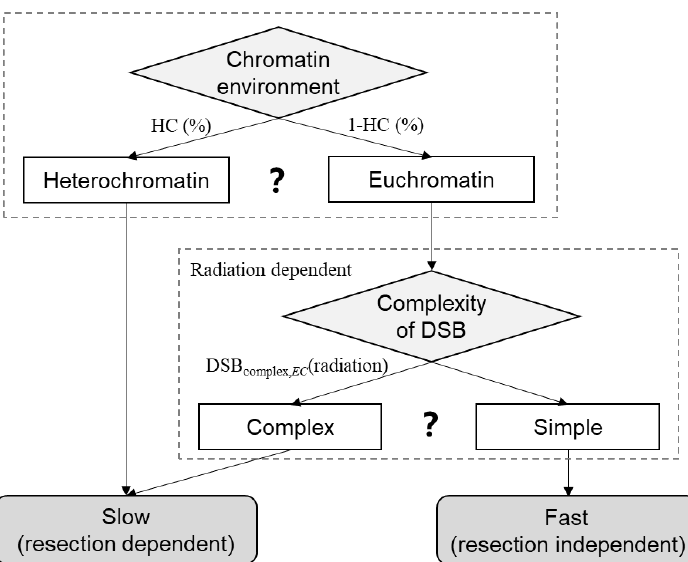
Figure 8. Scheme of the factors regulating the slow and fast repair compartments. HC is the fraction of heterochromatin. DSB complex,EC (radiation) is the fraction of complex DSB in the DSB located in eu-chromatin.